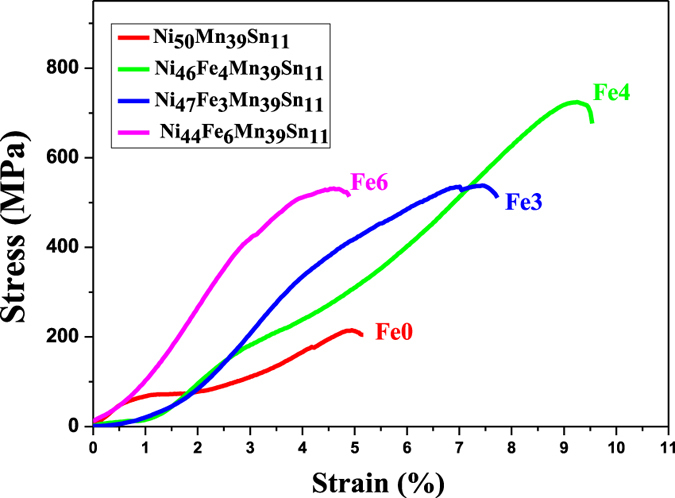
The compressive stress-strain curves of Ni50−xFexMn39Sn11 alloys at room temperature.